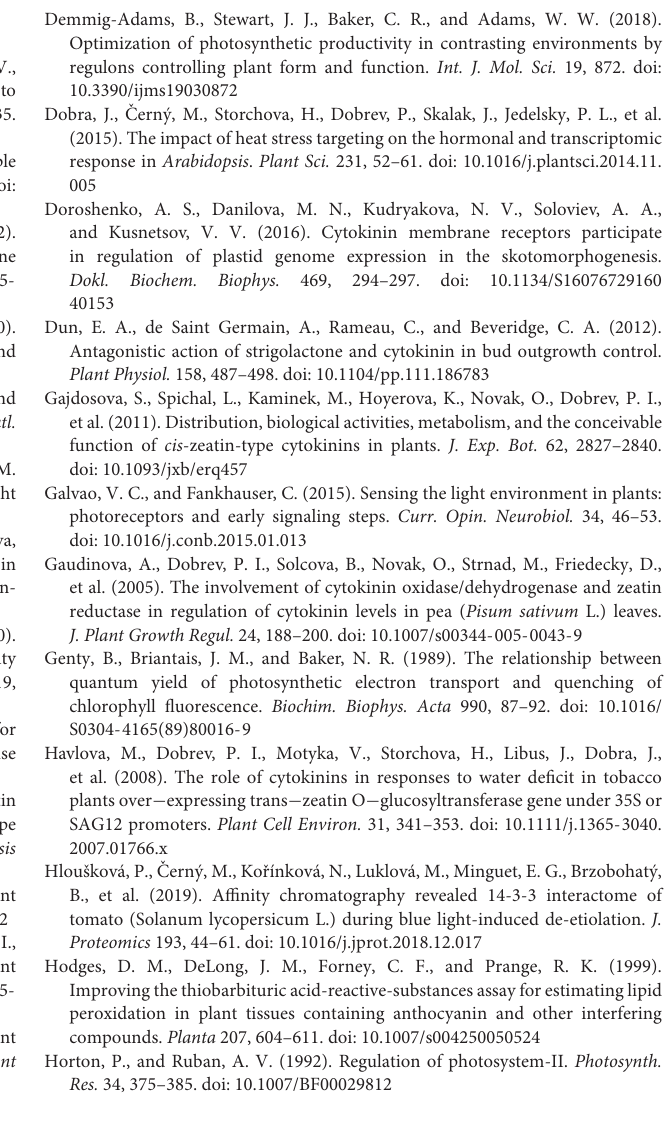
Supplementary Table 1 | List of qPCR primers. Supplementary Table 2 | Phytohormones. Supplementary Table 3 | Transcriptomic